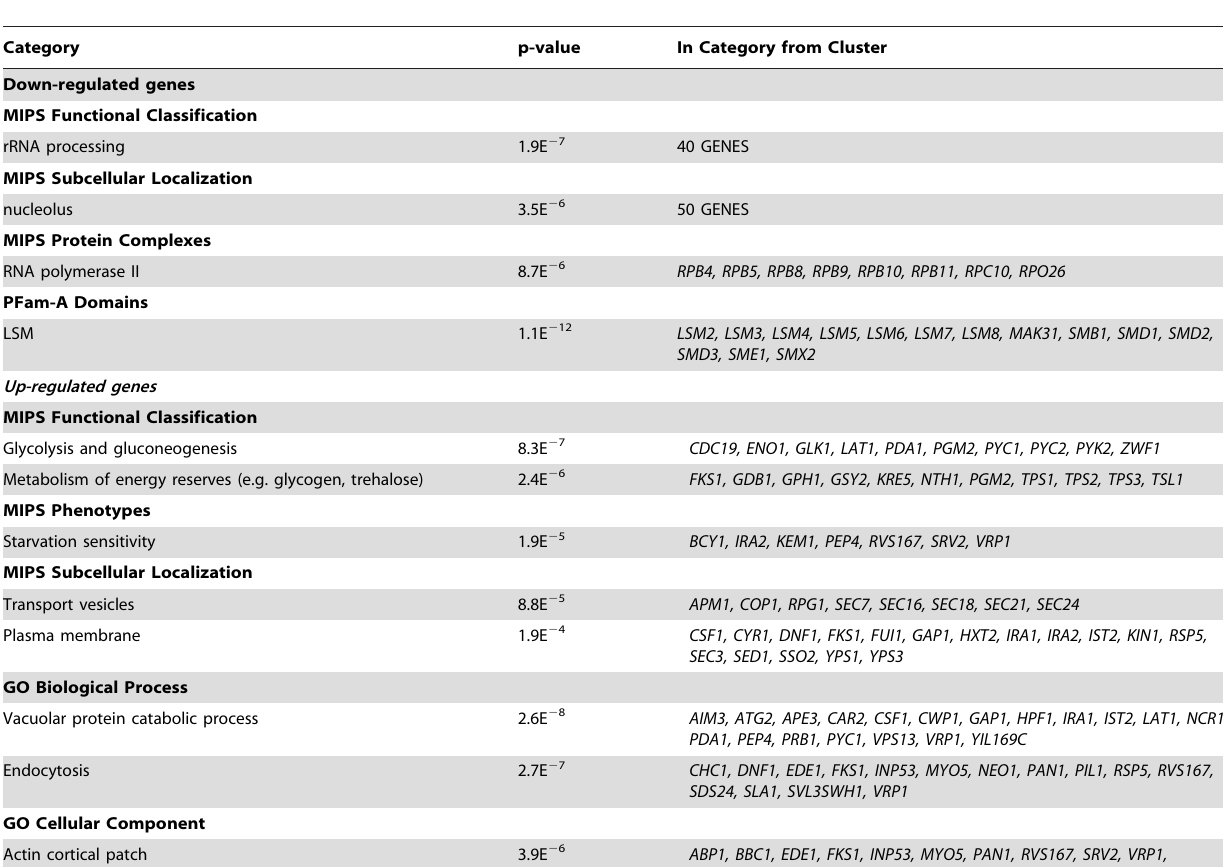
Table 1. Functional categories overrepresented in the microarray